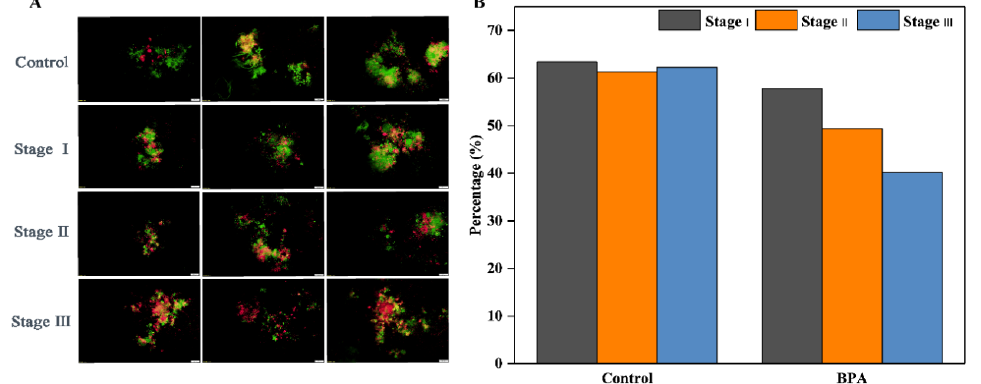
Figure 3. The effect of bisphenol A (BPA) on the microbial activity of sequencing batch reactor (SBR) activated sludge. ( A ) Fluorescence staining of activated sludge microorganisms in different reaction stages; ( B ) The ratio of viable microorganisms in activated sludge in different reaction. Note: The three images are parallel samples of the same stage.